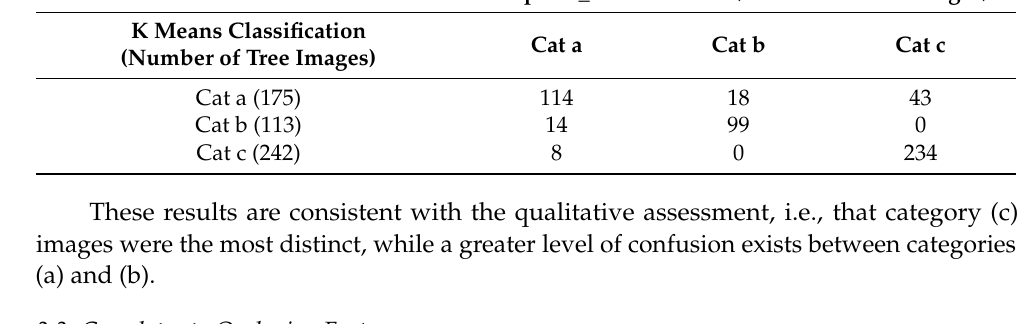
Table 8. Classification relative to ground truth categories from k-means clustering (values in brackets) for the Xception_classification model. Results are of a test set, i.e., 2017 orchard C (530 images of 265 trees) using a model trained on orchard A images (988 images of 494